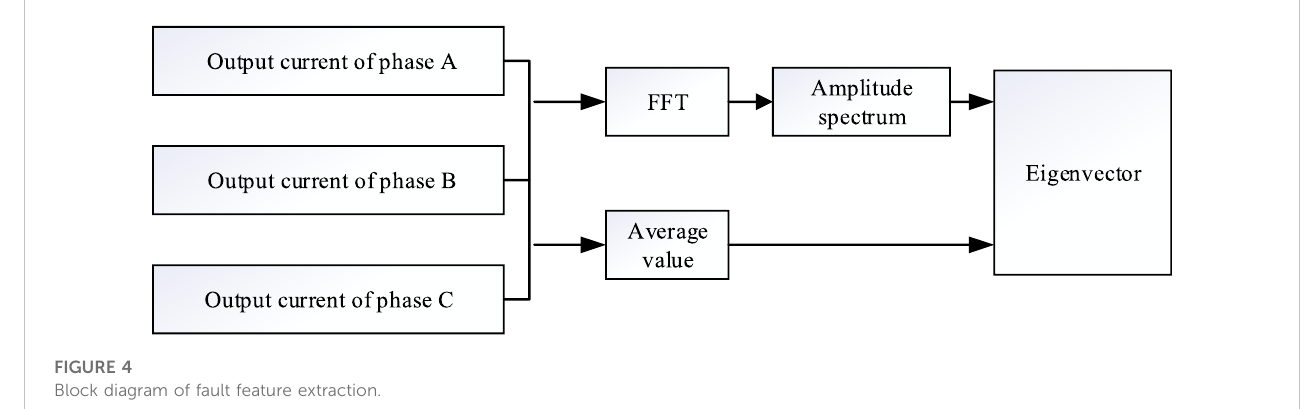
FIGURE 4 Block diagram of fault feature extraction.